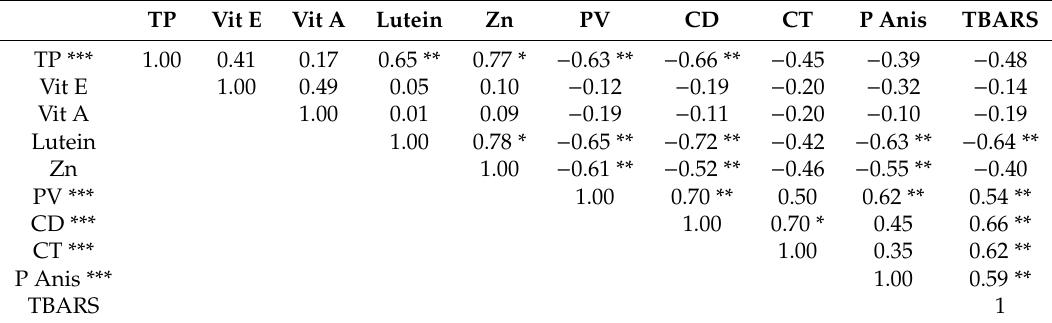
Table 7. Correlations between nutrients with antioxidant activity and lipid peroxidation